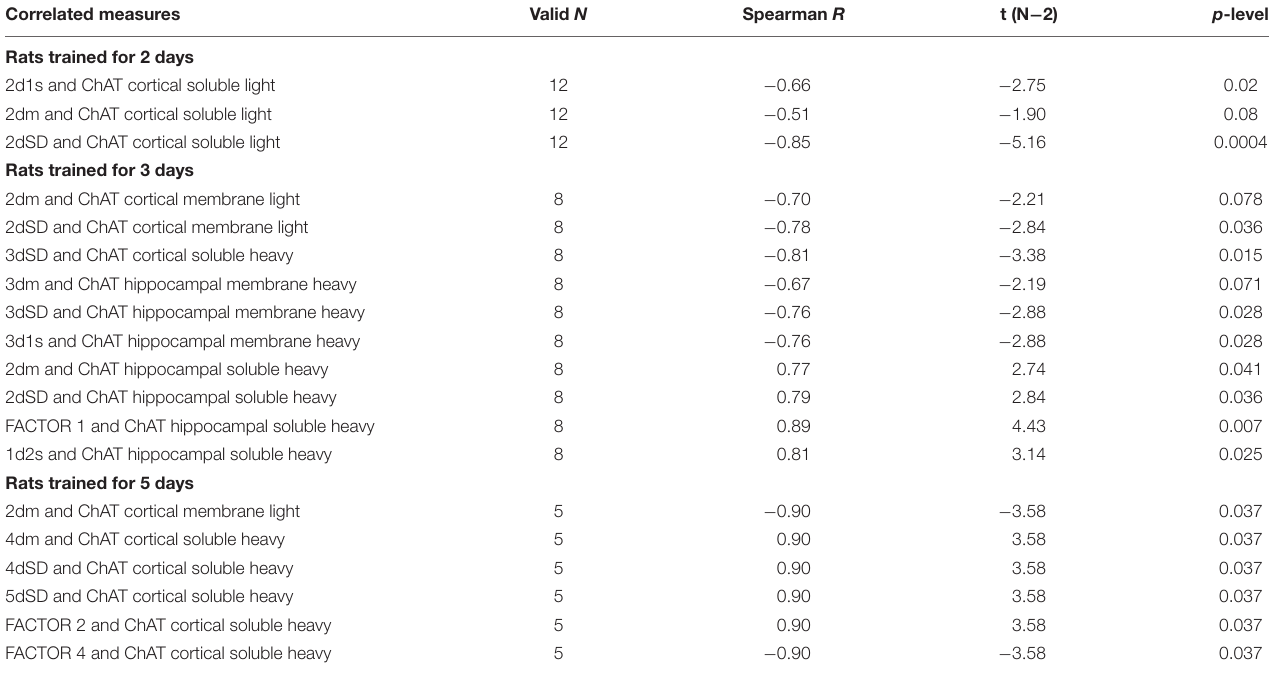
TABLE 2 | Correlations between choline acetyltransferase (ChAT) activity and Morris water maze (MWM) performance in rats trained for 2, 3, or 5 days. Correlated measures Valid